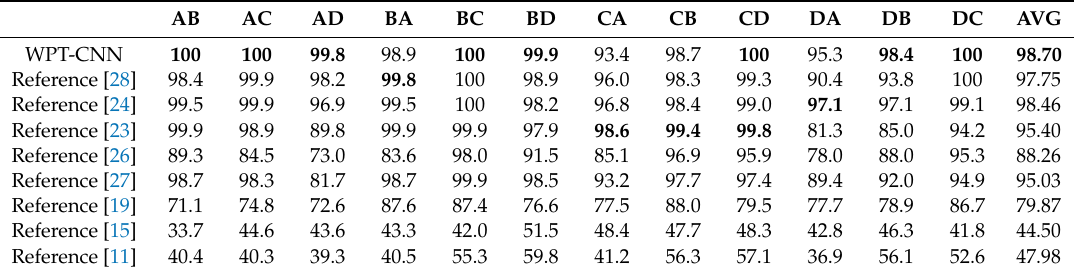
Table 13. Comparison of the transfer-learning ability of various